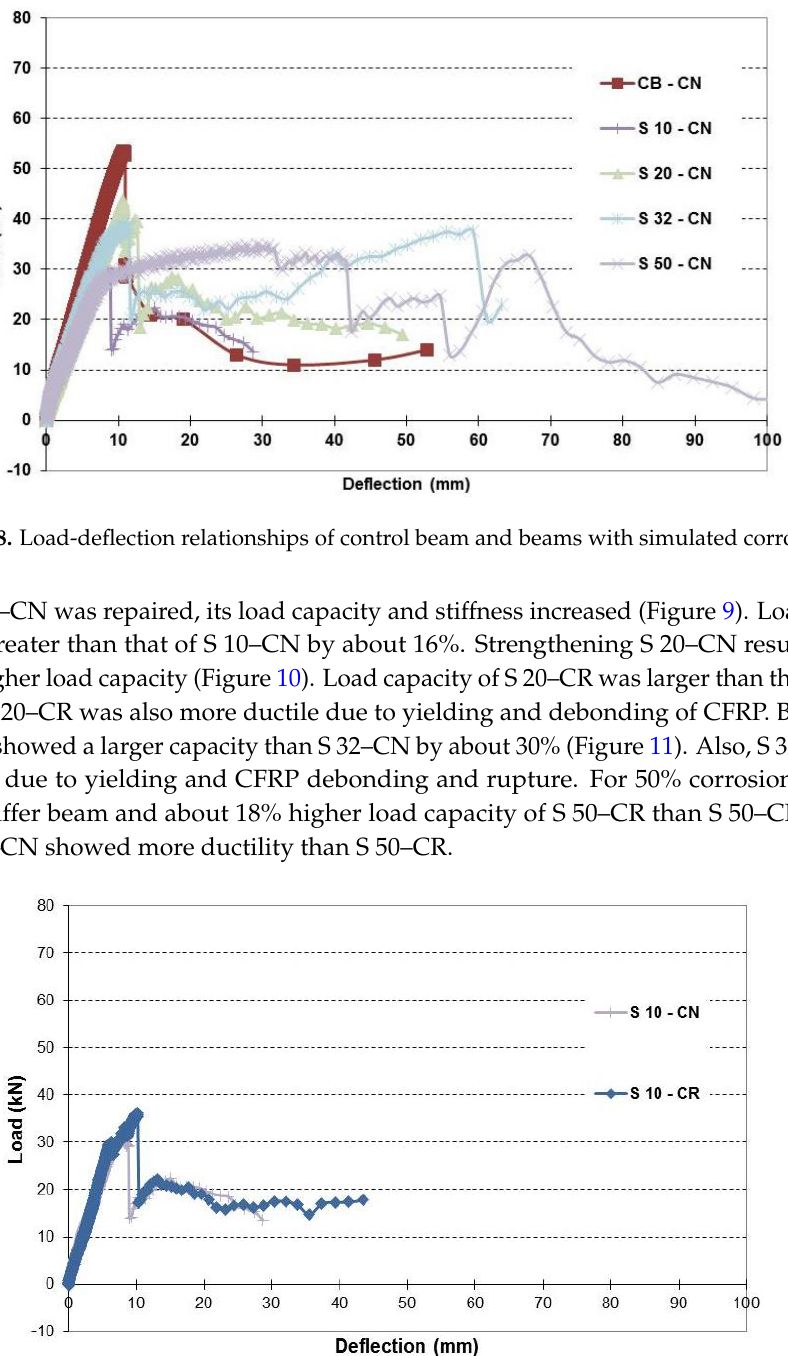
Figure 9. Load-deflection relationship of beams with simulated 10% corrosion level.